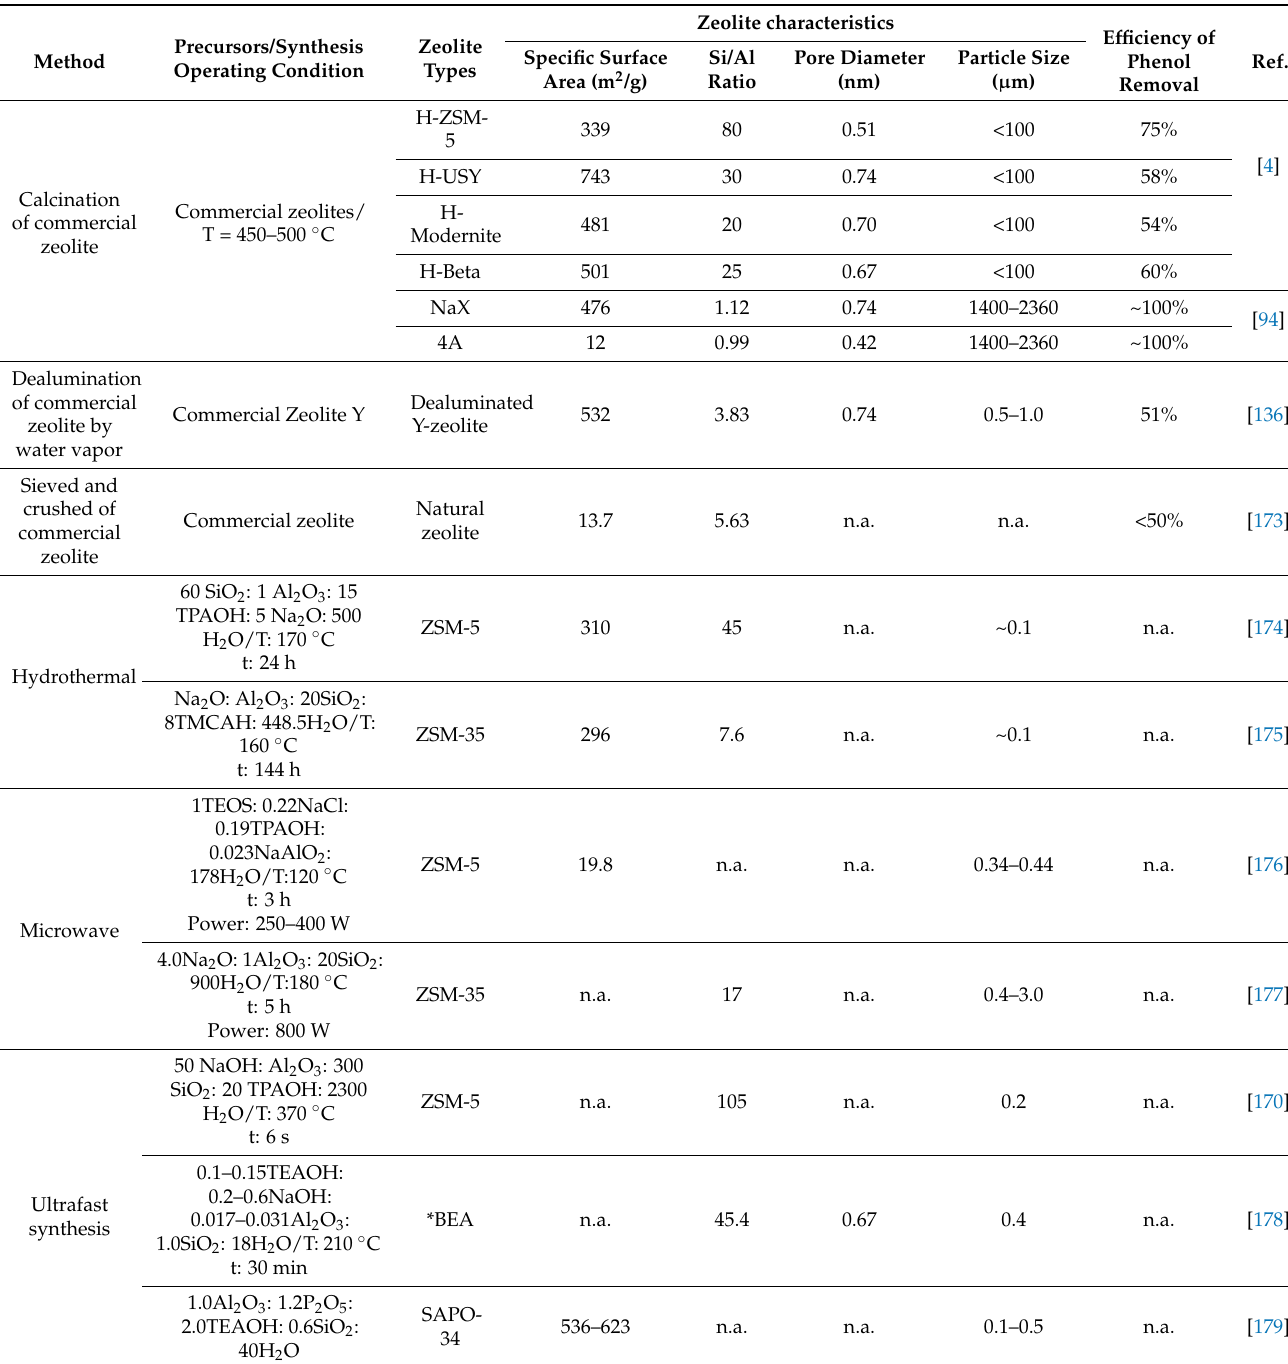
Table 17. Comparison of various zeolites synthesis methods on physiochemical characteristics and the efficiency of phenol